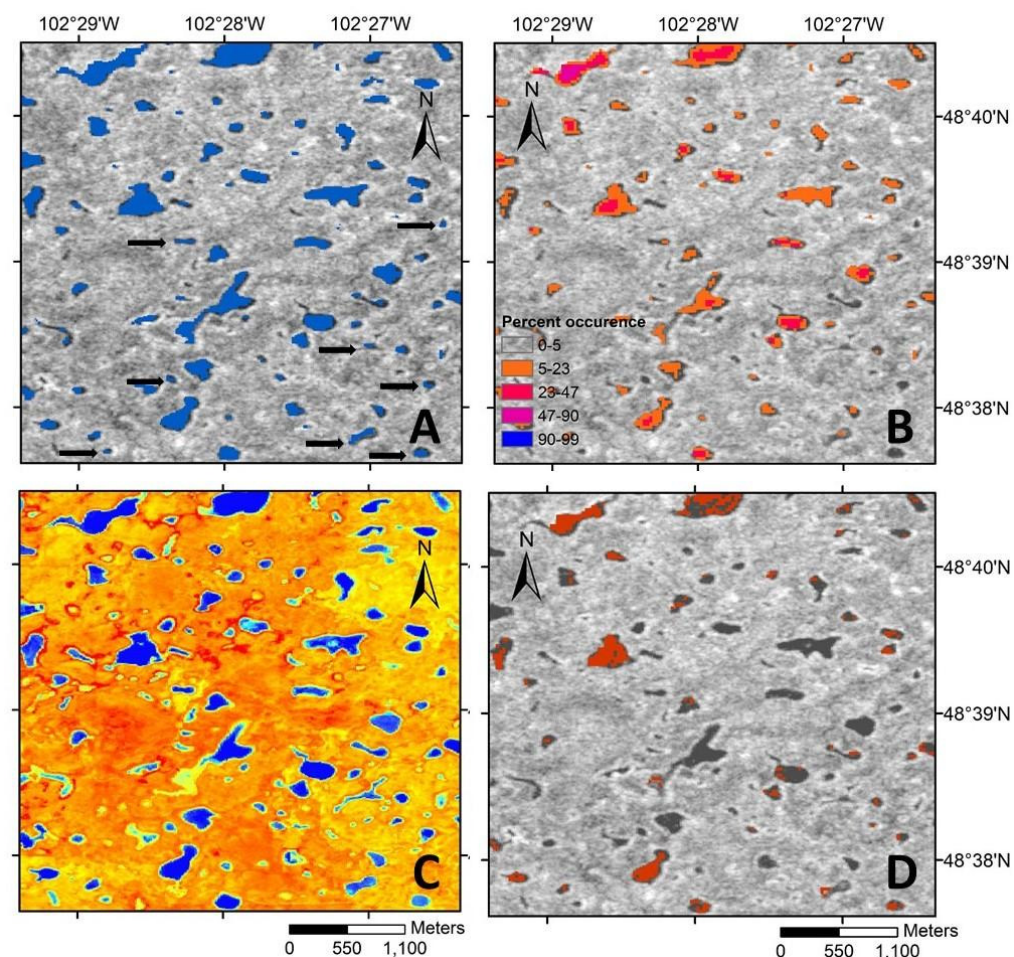
Figure 9. The result of wetland inundation maps for the year 2017 was obtained from the multisensor composite classification using random forest. The image shows the identified wetland. The background image is Sentinel-1 VV. The black arrows show some examples of those small wetlands that were not detected in the JRC ( A ); frequency of surface water occurrence from the year 1984 to 2019 obtained from the Landsat-derived JRC products ( B ); surface water visualization using the Sentinel-2 derived NDWI ( C ); water extent for the year 2017 derived from the Landsat-derived JRC product ( D ).